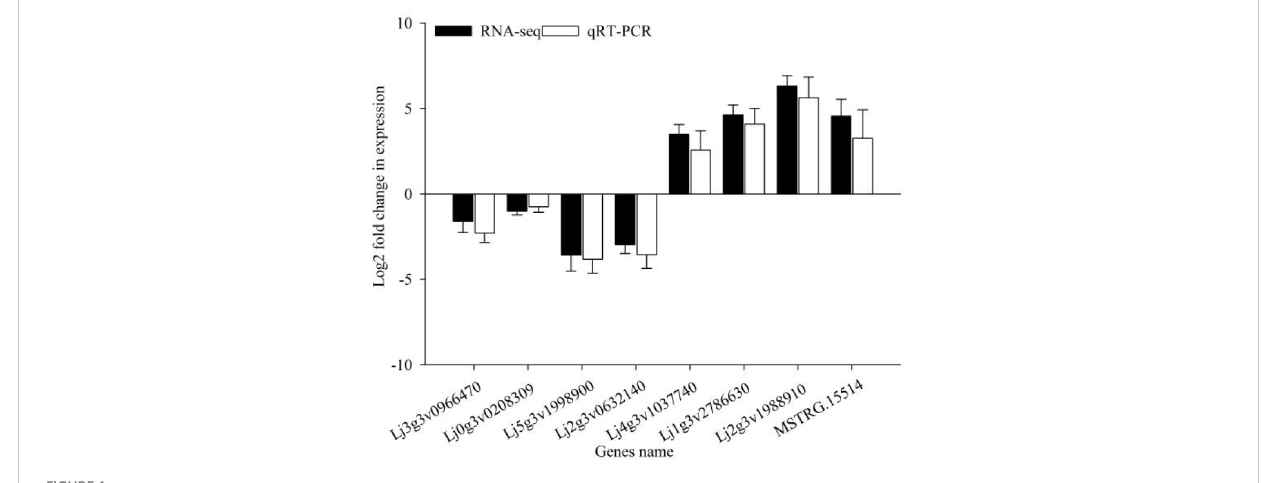
FIGURE 1 Validation of the transcript abundance of eight selected genes obtained from RNA-seq using qRT-PCR.